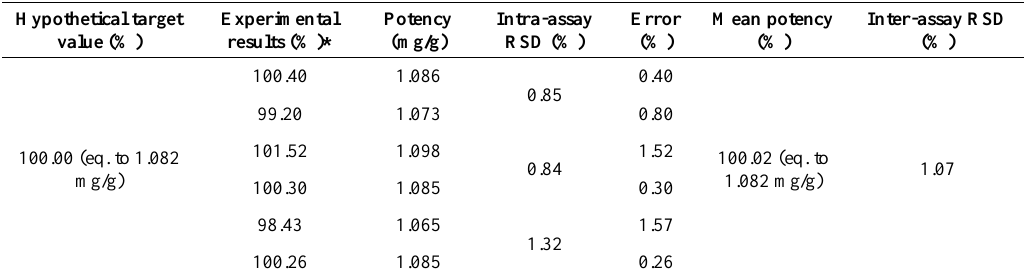
Figure 4. Fixed and relative bias detection and monitoring that showed the angular coefficient, including zero and one terms: (a) Method precision; (b) Method accuracy Table 3. Precision assessment result of PLM microbiological assay of Gentamicin Sulfate